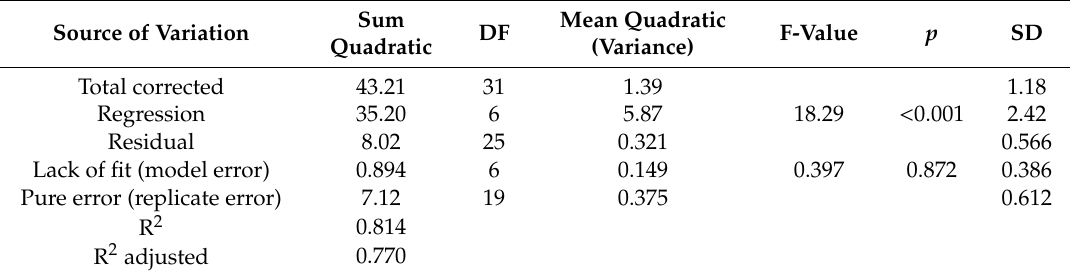
Table 3. ANOVA for the regression model on extraction of phenolic acids from leaf material. Source of